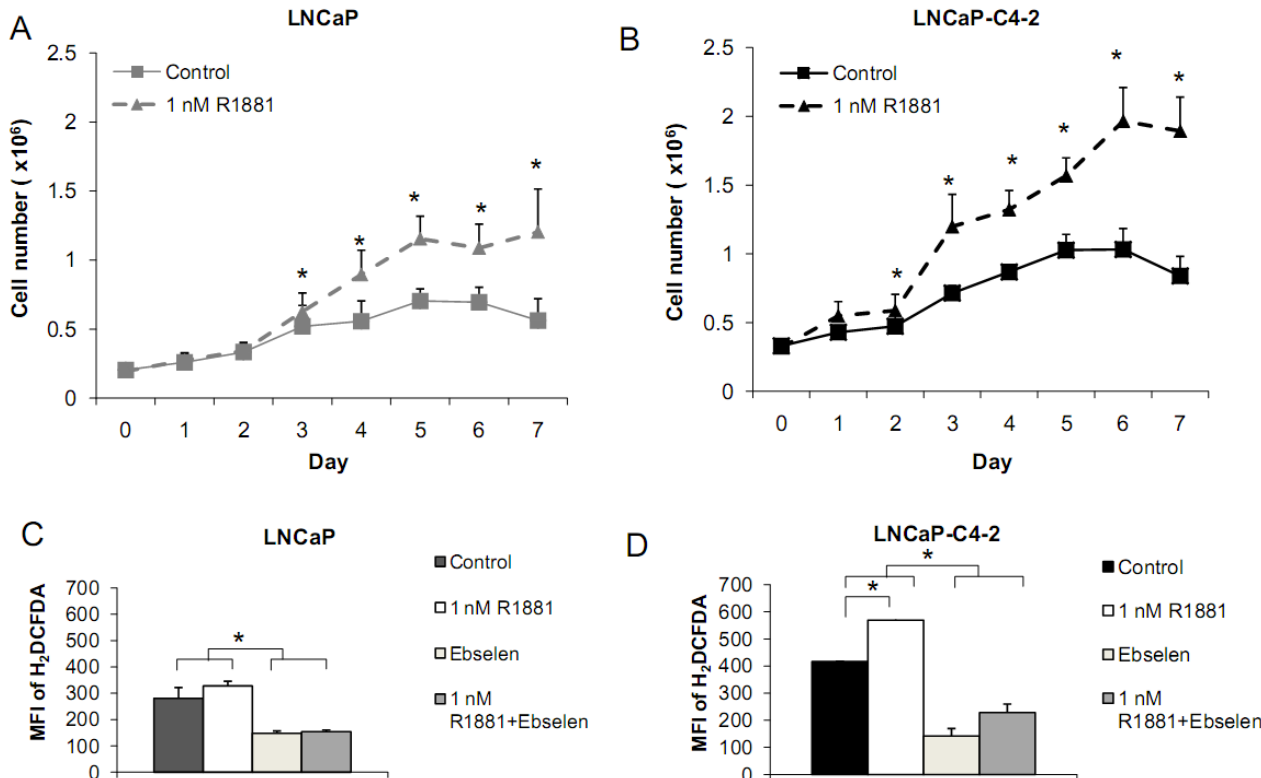
Figure 10. Effects of an androgen analog R1881 on LNCaP or LNCaP-C4-2 cell growth and ROS/RNS levels. ( A ) LNCaP cells or ( B ) LNCaP-C4-2 cells were cultured with 1 nM R1881 for 7 days. Cell numbers were counted every 24 h; ( C and D ) Flow cytometry analysis of intracellular ROS/RNS levels after LNCaP or LNCaP-C4-2 cells were treated with 1 nM R1881 ± 25 µ M Ebselen for 48 h. Cells (1 × 10 4 ) were collected during log phase and incubated with H DCFDA. CDCFDA (oxidation insensitive dye) was used to 2 normalize uptake, efflux, and ester cleavage of H DCFDA. Data are presented as MFI of 2 H DCFDA; MFI of CDCFDA of LNCaP and LNCaP-C4-2 cells were not significantly 2 different. * P-value ≤ 0.05 when compared to